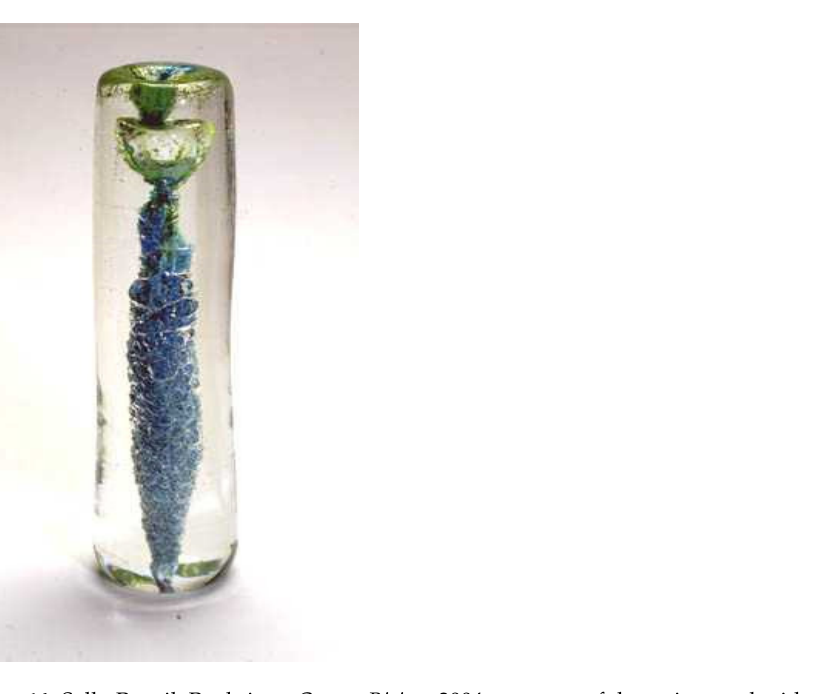
Figure 14. Sally Resnik Rockriver ; Copper Rising , 2004; courtesy of the artist, used with permission.